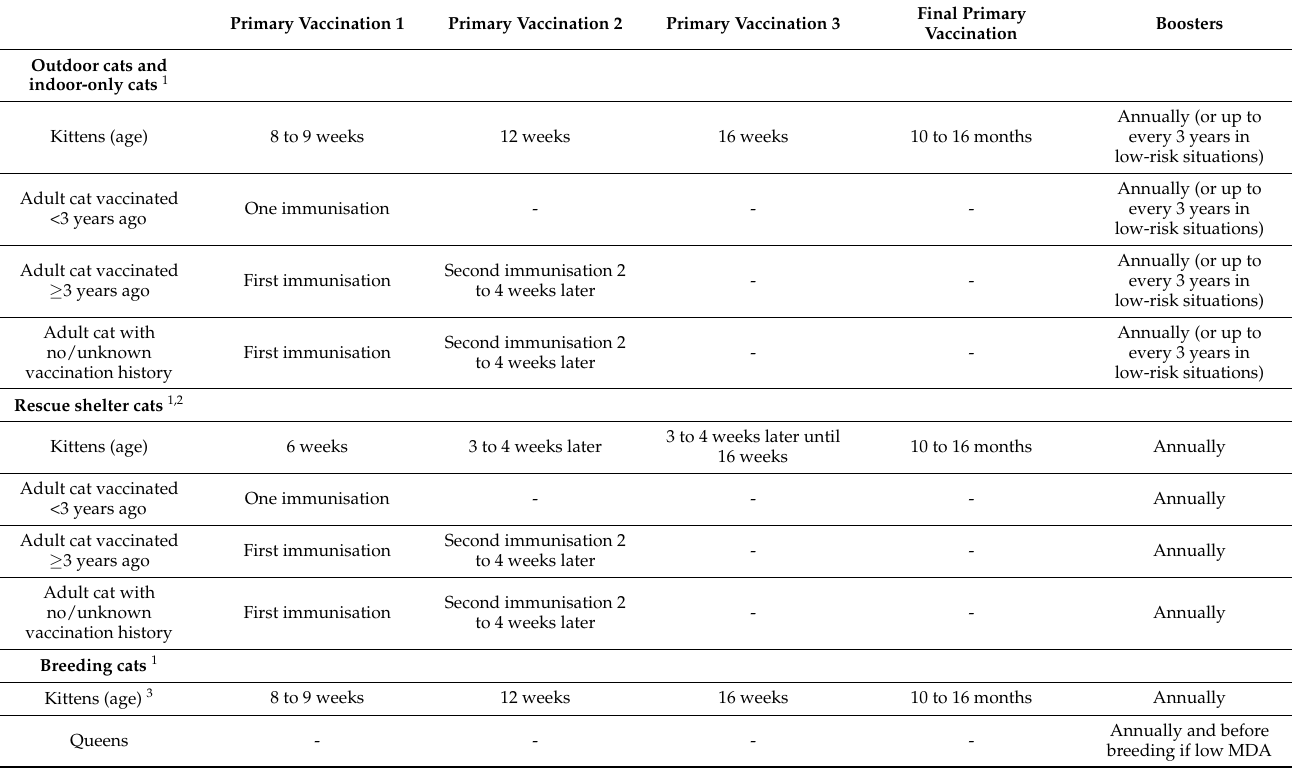
Table 1. Recommended FCV vaccination course in outdoor cats and indoor-only cats, rescue shelters cats and breeding cats (FCV is usually vaccinated in combination with FPV and FHV) (according to [159]). These vaccine recommendations are updated regularly and the latest version can be downloaded at